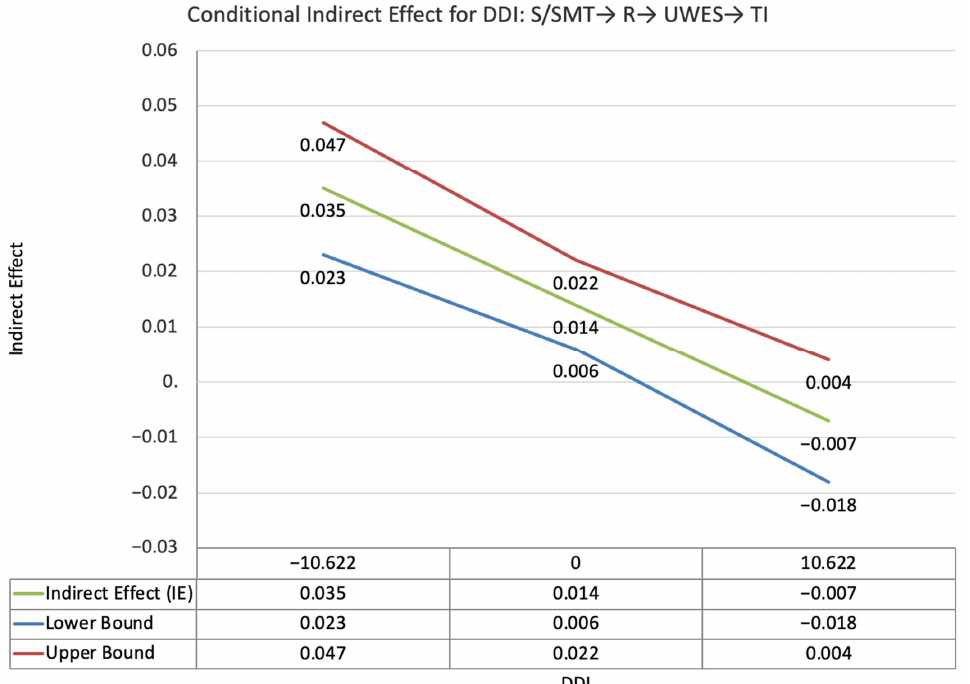
Figure 9. Conditional indirect effects of the difference between self-PMIEs compared to the control group on turnover intentions at low, average and high levels of self-disclosure, through relatedness satisfaction and work engagement.